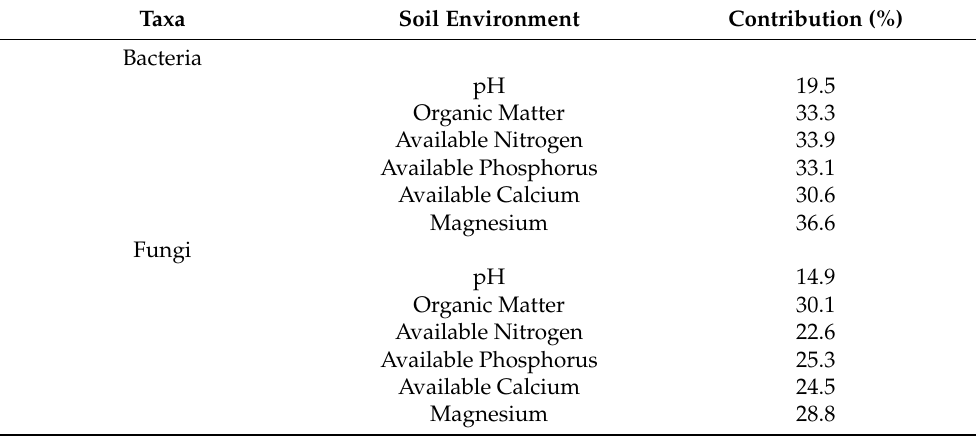
Table 3. Contribution of soil environment to bacteria and fungi taxa at the genus level.